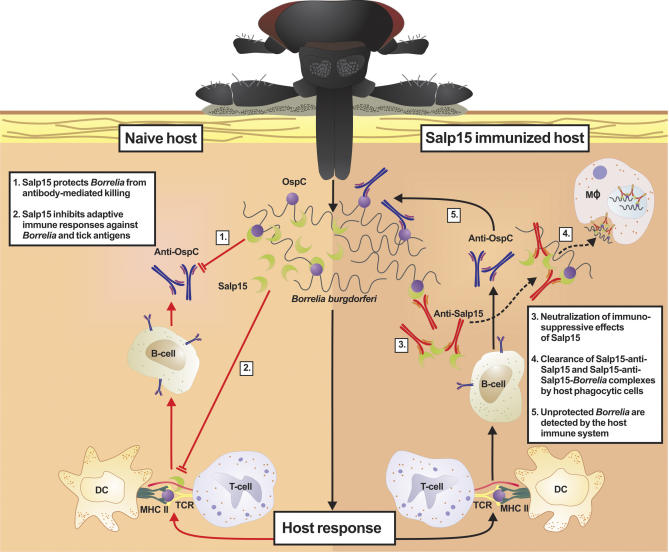
Diagram Showing How an Anti-Salp15 Vaccine Could Prevent Transmission of B. burgdorferi
During tick feeding and early mammalian infection, B. burgdorferi expresses OspC, which binds to Salp15 in tick saliva. This binding acts as a shield and protects the spirochete from killing by the host. In addition, Salp15 has been shown to directly inhibit dendritic cell and T cell activation, which could facilitate tick feeding. Salp15 antibodies are likely to bind to Salp15 that has previously bound to OspC on the surface of B. burgdorferi in the tick salivary gland and could thereby enhance clearance by host phagocytic immune cells. Obviously, the Salp15 antibodies would need to recognize a Salp15 epitope other than the epitope that is required for binding of Salp15 to OspC. Similarly, if anti-Salp15 antibodies were to bind to free Salp15, they could neutralize the immunosuppressive effects of Salp15, which could hamper tick feeding and thereby transmission of B. burgdorferi from the tick to the host. Lastly, if anti-Salp15 antibodies were to inhibit binding of Salp15 to Borrelia OspC, this would render the spirochete susceptible to pre-existing or newly generated immunoglobulins. Importantly, Salp15 was originally identified by screening of a tick salivary gland cDNA expression library with tick immune rabbit sera, suggesting that antibodies against Salp15 may participate in tick rejection.DC, dendritic cell; MHC, major histocompatibility complex; MF, macrophage; TCR, T cell receptor.